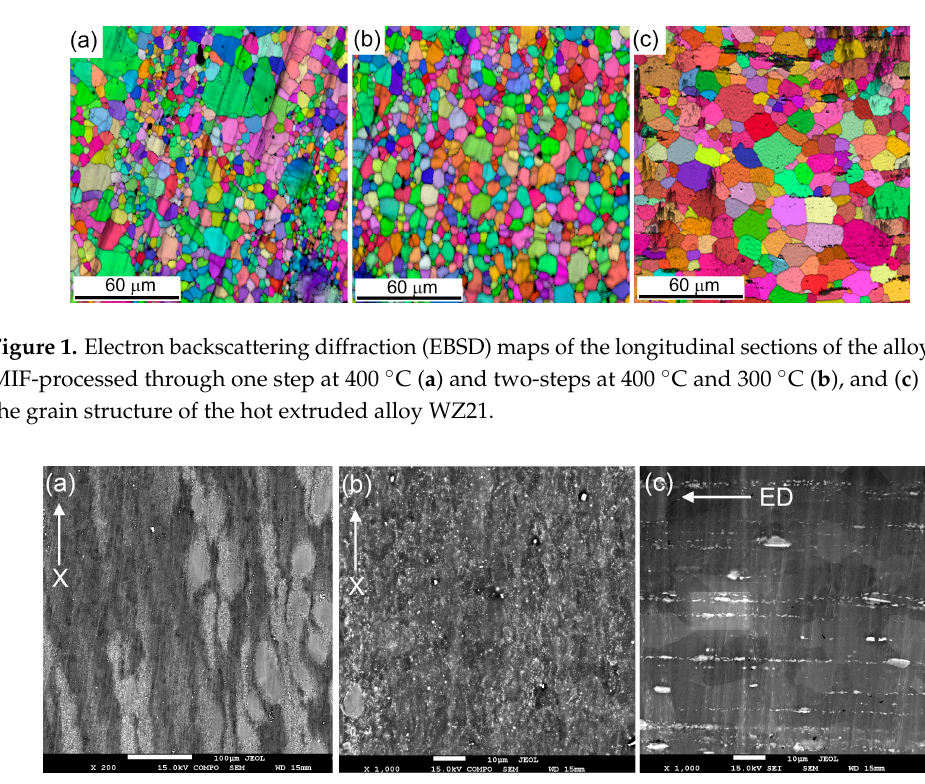
Table 1. Properties of Mg alloys tested.